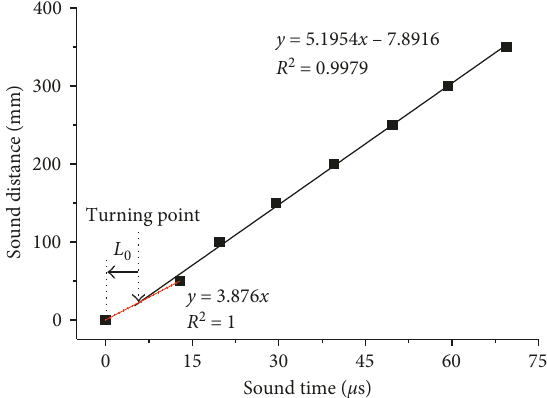
Figure 10: Calculation chart for L